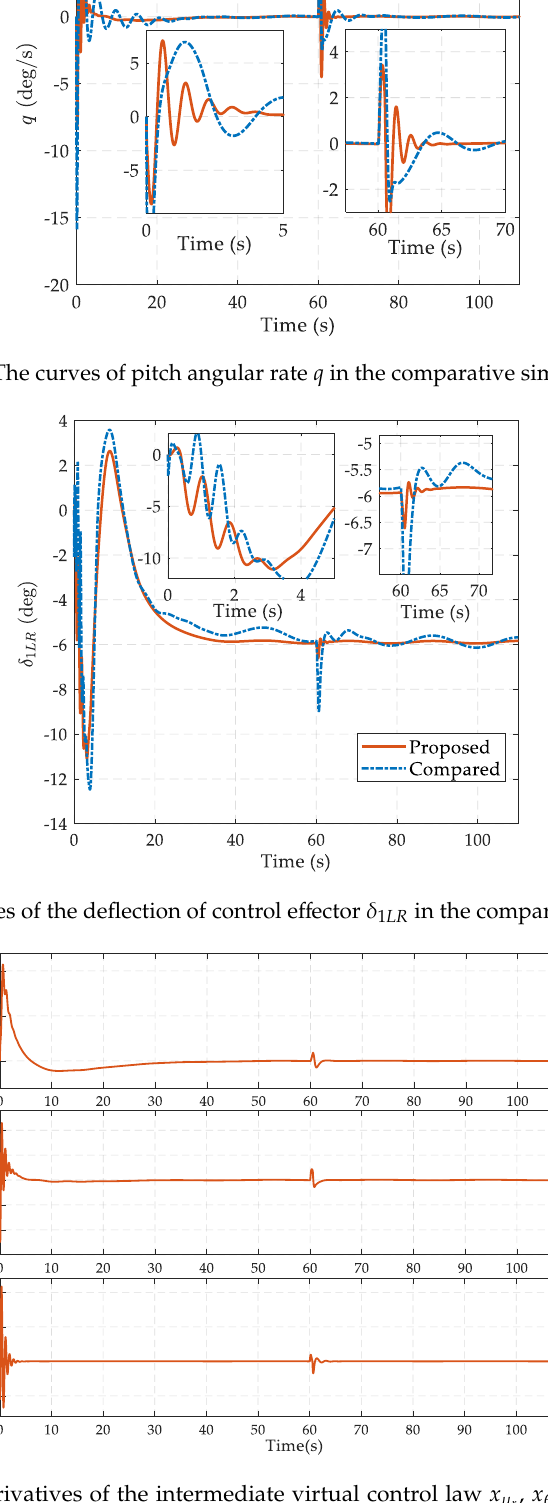
Figure 8. The time derivatives of the intermediate virtual control law x µ by finite-time convergent differentiators (FTCDs).